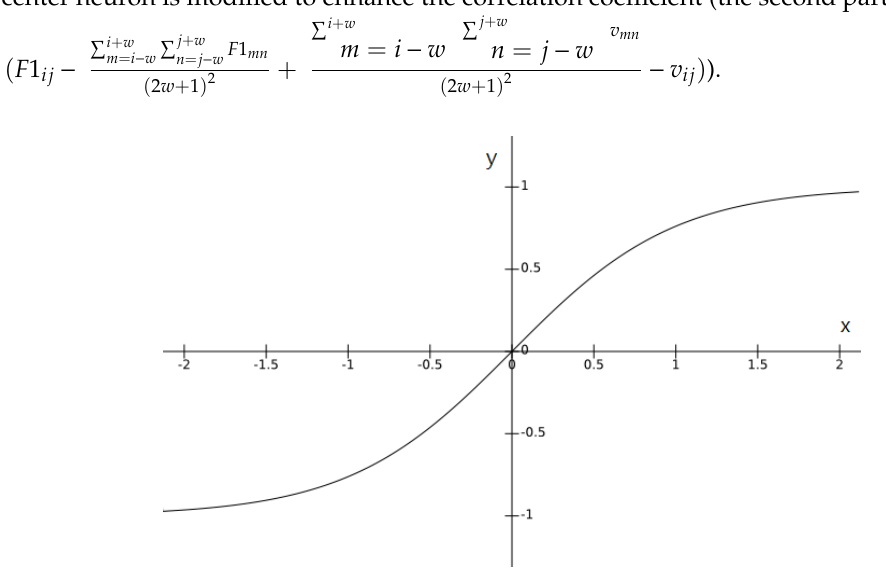
Figure 4. The graph of y = tanh(x).